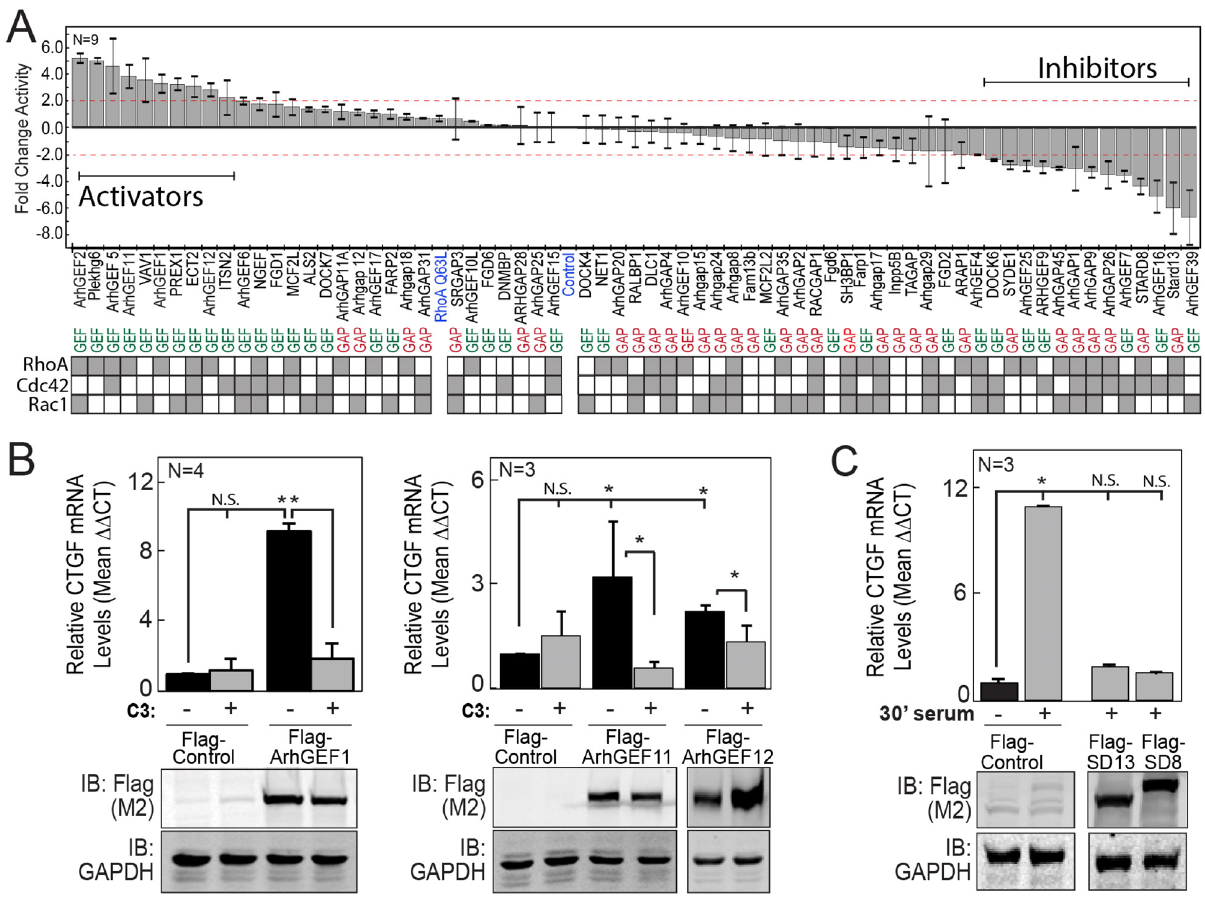
Figure 1. Candidate expression screen for Rho GEFs and GAPs that regulate YAP1-dependent transcription. ( A ) Mean fold-change in normalized TEAD reporter activity in BT474 cells expressing the indicated Flag- tagged RhoGEFs or RhoGAPs versus a Flag-control. Cells were also transfected with YAP1, the TEAD reporter and TK-Renilla (top panel). Activators and inhibitors mark twofold or greater effects. GEF (Green) or GAP (Red) domain identities are aligned with the genecard.org selectivity for RhoA, Rac1 and Cdc42 (bottom panel). ( B ) Fold-change in CTGF transcript levels as measured by qRT-PCR from cDNA synthesized from total mRNA isolated from MCF7 cells transfected for 48 h with plasmids expressing Flag control or a Flag-tagged RGS- RhoGEF in combination with control plasmid or a plasmid that expresses the C3 exotransferase (top panels). Immunoblot analysis of protein lysates from replicate samples using antibodies against the Flag-tag and GAPDH (bottom panels). ( C ) Fold-change in CTGF transcript levels from MCF7 cells transfected with a control plasmid or plasmids that express either the STARD13 (SD13) or STARD8 (SD8) RhoGAPs. Cells were cultured in serum free media for 24 h and then treated for 30 m with media containing either 0% (−) or 10% (+) fetal bovine serum. Data represent mean values, error bars show standard deviation of mean. Variability unless indicated otherwise was queried by one-way ANOVA. *p-value < 0.05 from contrasts identified by the Bonferroni Multiple Analysis Test; N.S. = non-significant contrasts of interest. Raw images for all immunoblots are in Figs. S6 and